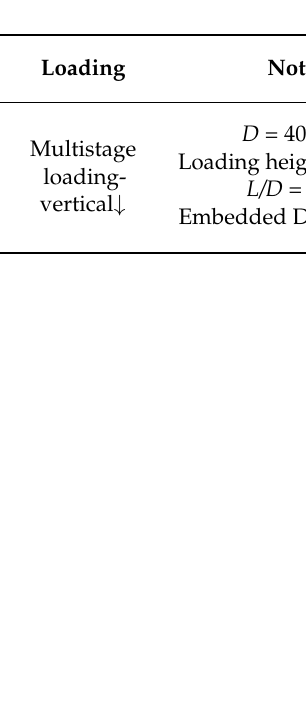
Figure 1. The definition of parameters and local coordinate system.